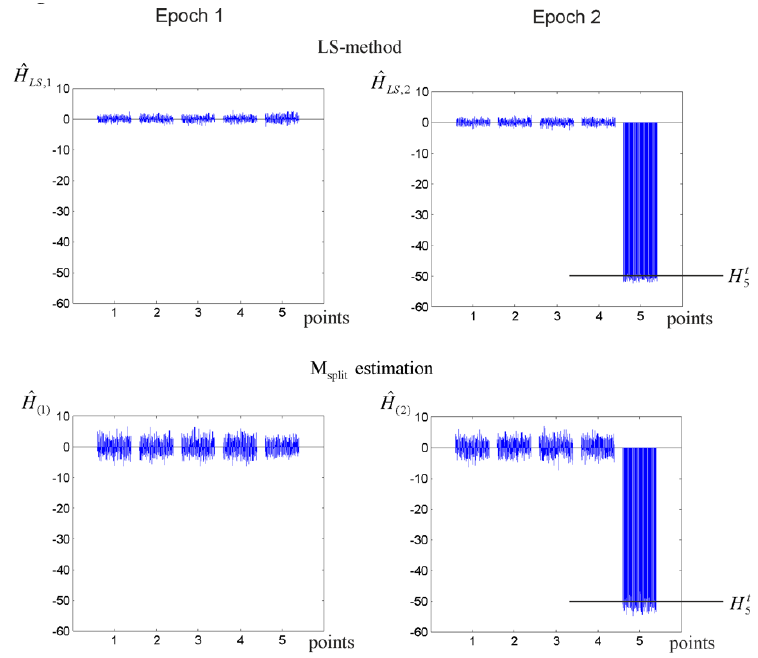
Figure 6. The LS and M split estimates of the MC simulations ( ∆ H 5 ( 1,2 ) = − 50 mm).